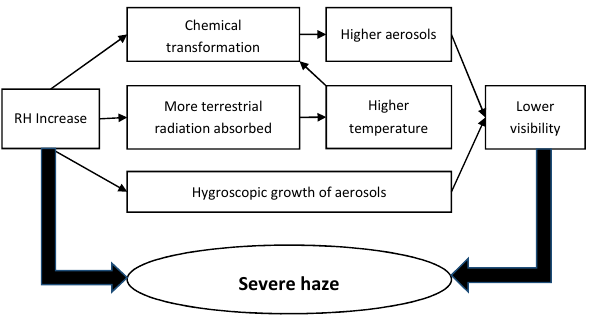
Figure 16. The mechanism of how RH influenced haze